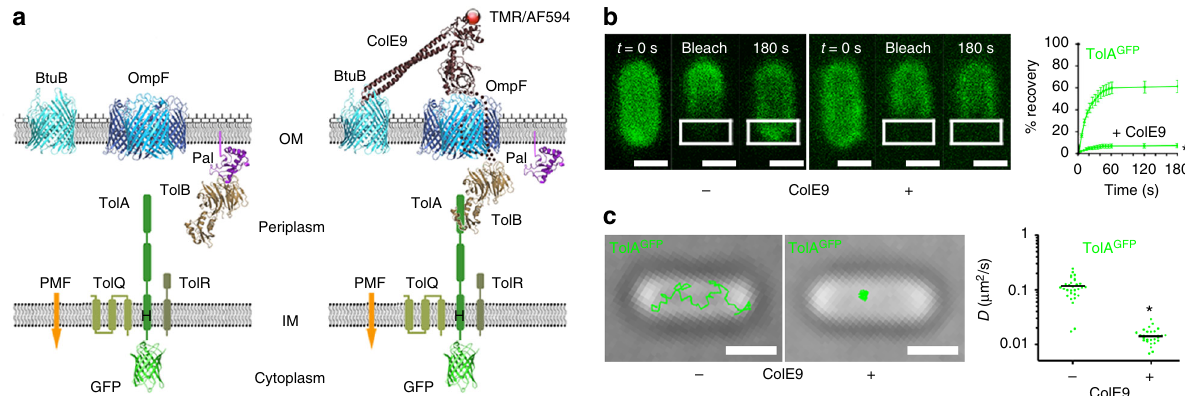
Fig. 1 OMP-bound ColE9 reduces the lateral mobility of TolA in the IM. a Left-hand panel, central components of the Tol-Pal complex (TolQ, TolR and TolA in the IM, TolB in the periplasm and the lipoprotein Pal in the OM) and the OMPs BtuB and OmpF. ColE9 exploits all these proteins during its import with the exception of Pal. TolA was tagged with GFP at its N-terminus while TolQ was fused to mCherry at its C-terminus (not shown). Also shown is the location of a histidine residue (H22) in the transmembrane helix of TolA that is critical for coupling to the PMF via TolQ and TolR 36 . Right-hand panel, binding of fl uorescently labelled nuclease bacteriocin ColE9 to BtuB/OmpF recruits TolB, which in turn binds TolA in the IM 43 and establishes a protein bridge across the cell envelope. The colicin contains an internal disulphide bond that blocks import. Figure adapted from Rassam, P., Copeland, N.A., Birkholz, O., Tóth, C., Chavent, M., Duncan, A.L., Cross, S.J., Housden, N.G., Kaminska, R., Seger, U., Quinn, D.M., Garrod, T.J., Sansom, M.S.P., Piehler, J., Baumann, C.G. & Kleanthous, C. Supramolecular assemblies underpin turnover of outer-membrane proteins in bacteria. Nature 523 , 333 – 336 (2015). b Confocal FRAP data for E . coli JW0729/pNP4, pRP5 cells expressing GFP-TolA (not induced) and BtuB (induced), respectively, in the absence ( − ) and in the presence ( + ) of ColE9 (300 nM) and the corresponding recovery curves (averages from 30 cells). Asterisk, p < 0.01 from a Student ’ s t test. c Single- molecule TIRFM tracking data of GFP-TolA in the IM before and after ColE9 forms its transenvelope complex showing how OMP-bound colicin restricts the lateral mobility of TolA. Measurements of the TolA diffusion coef fi cient from mean square displacement plots of single-molecule trajectories are shown alongside, where n = 30. Those of TolA in the presence of ColE9 are typical of OMPs such as BtuB 16 . Asterisk, p < 0.001 from a Mann – Whitney U